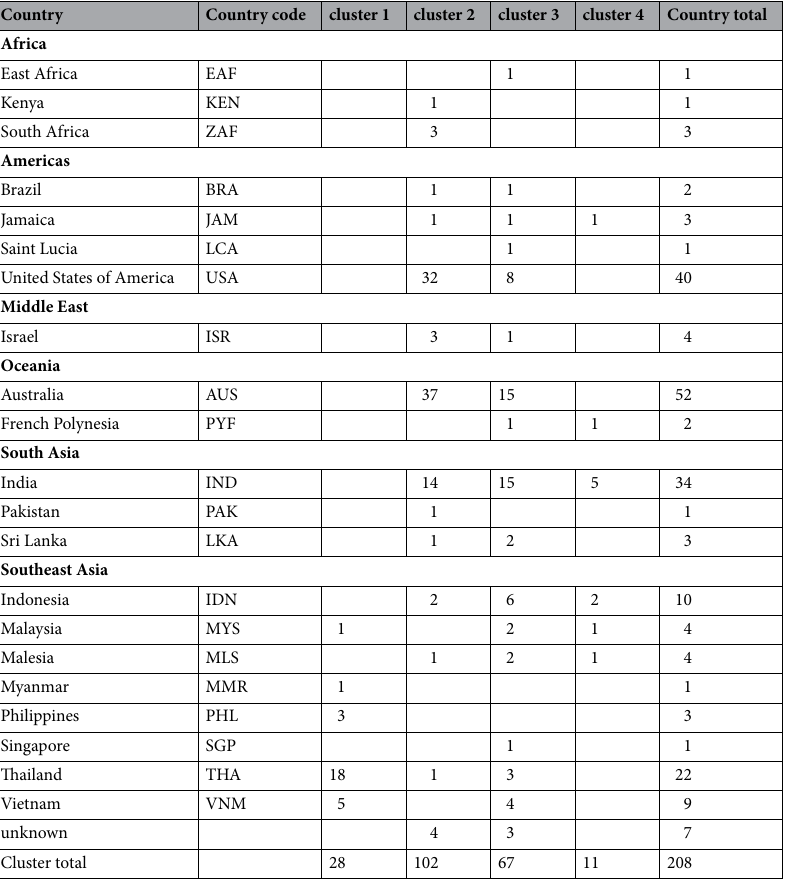
Table 1. The number of accessions of M. indica from each country of import and their assigned genetic clusters from the hierarchical cluster analysis for K = 4 calculated from 272 biallelic SNPs. Countries have been grouped into six geographical regions of